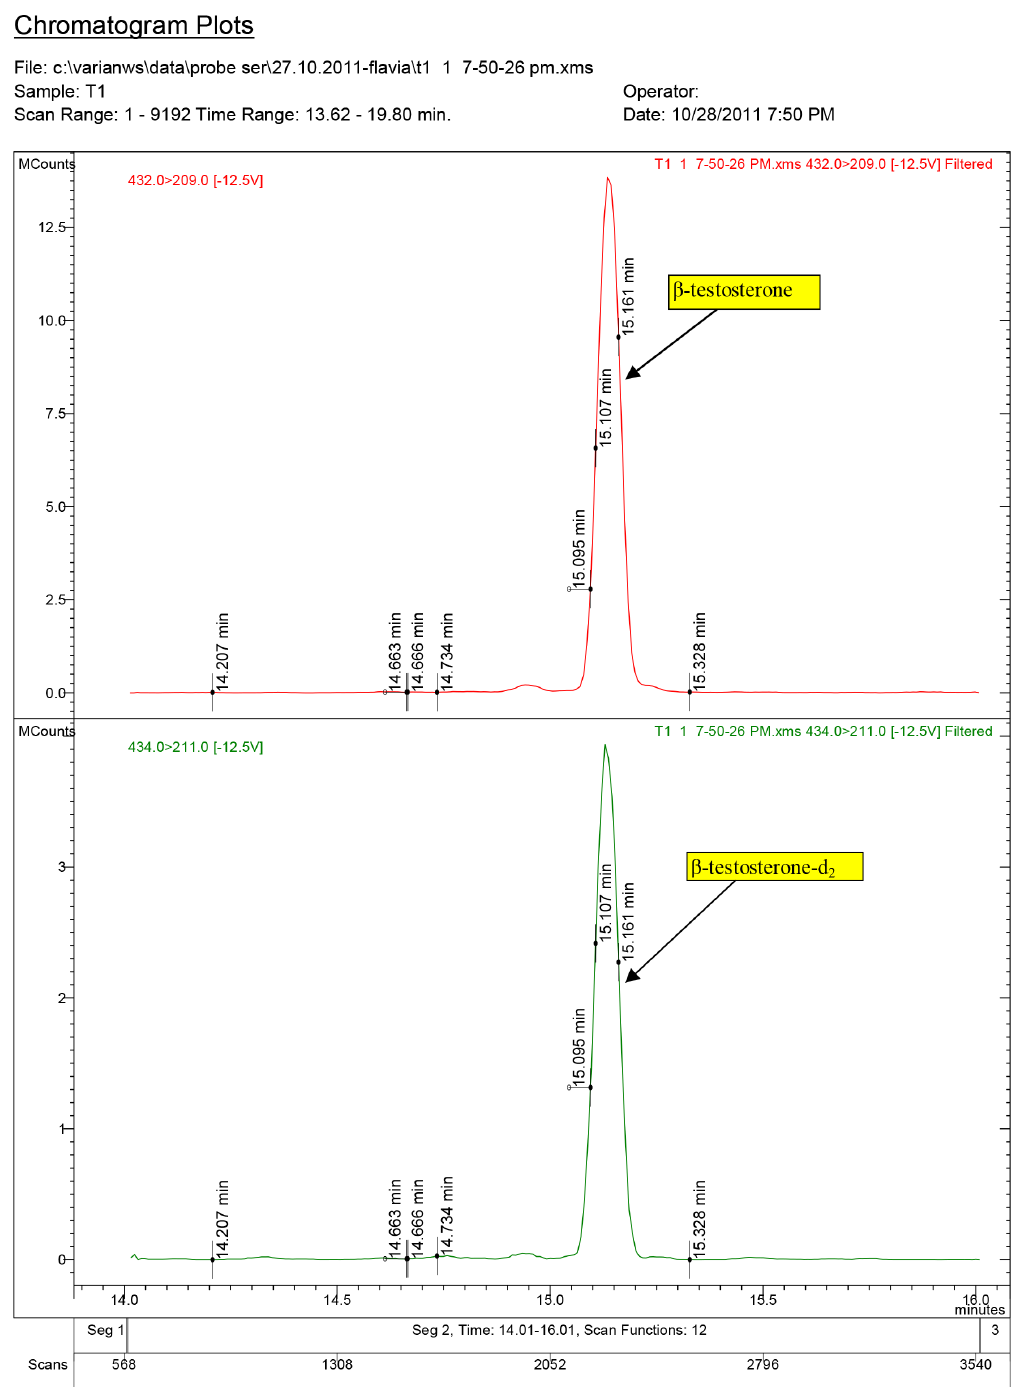
Figure 4. Diagnostic ions for serum sample no. T1, where 17 b -testosterone was quantified at 4.40 ng/ml (ppb) (group T1, dose: 1.5 mg/kg.bw).